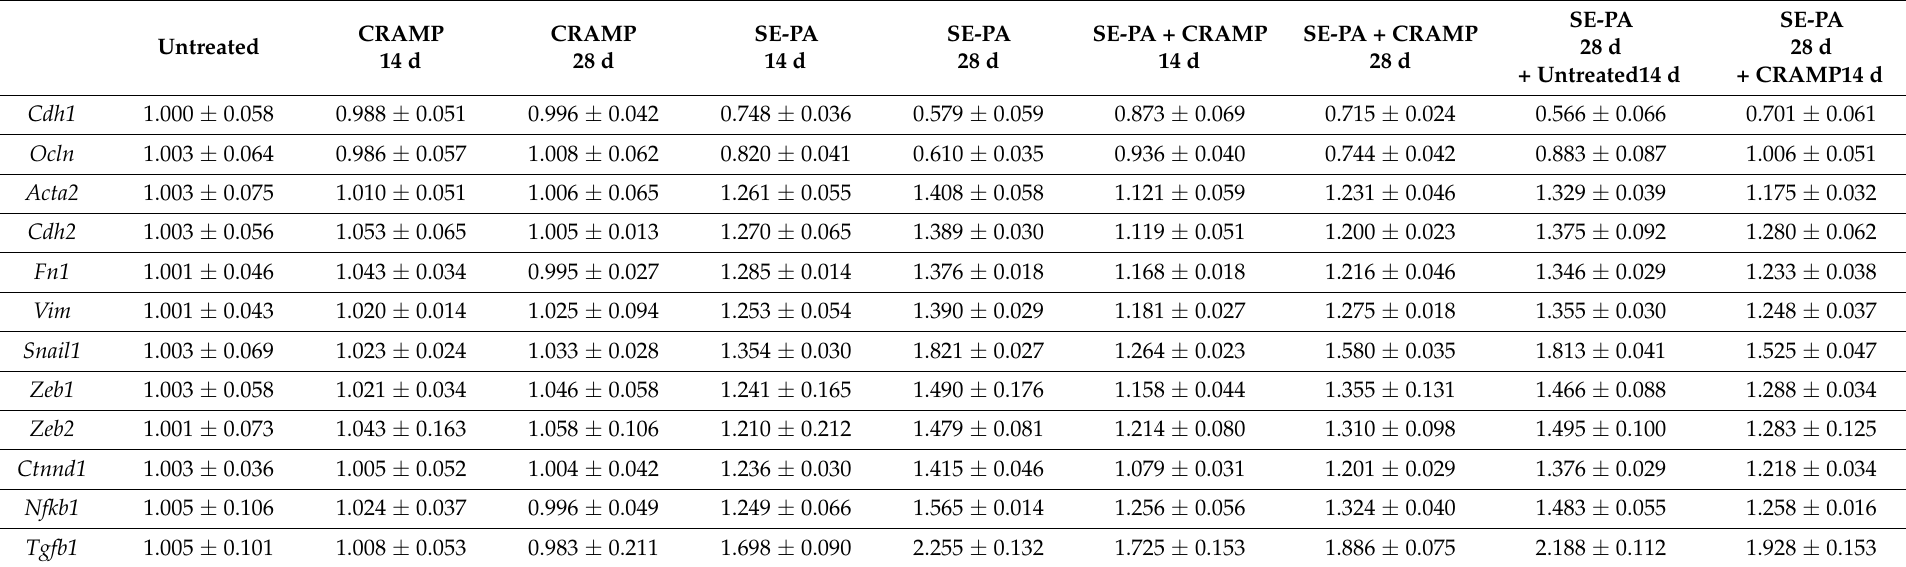
Table 1. Expression of genes involved in EMT in response to cathelicidin (CRAMP) and/or saline extract of Pantoea agglomerans (SE-PA) treatment. Results are presented as the mean of relative mRNA amount ±